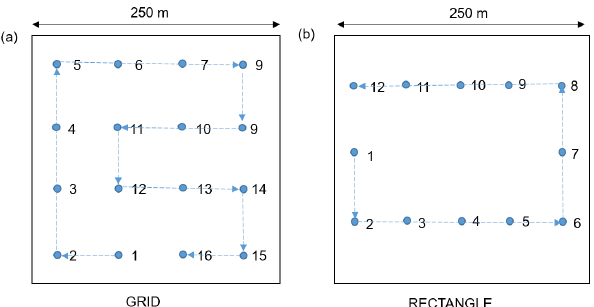
Figure A1. Waypoints for GRID (a) and RECTANGLE (b) flight